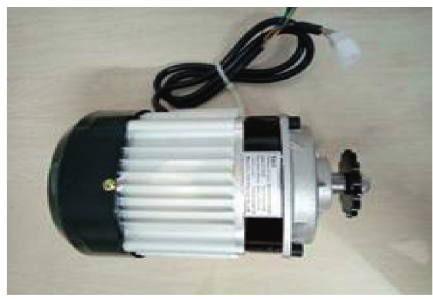
Figure 5: Model of the BLDC motor drive.